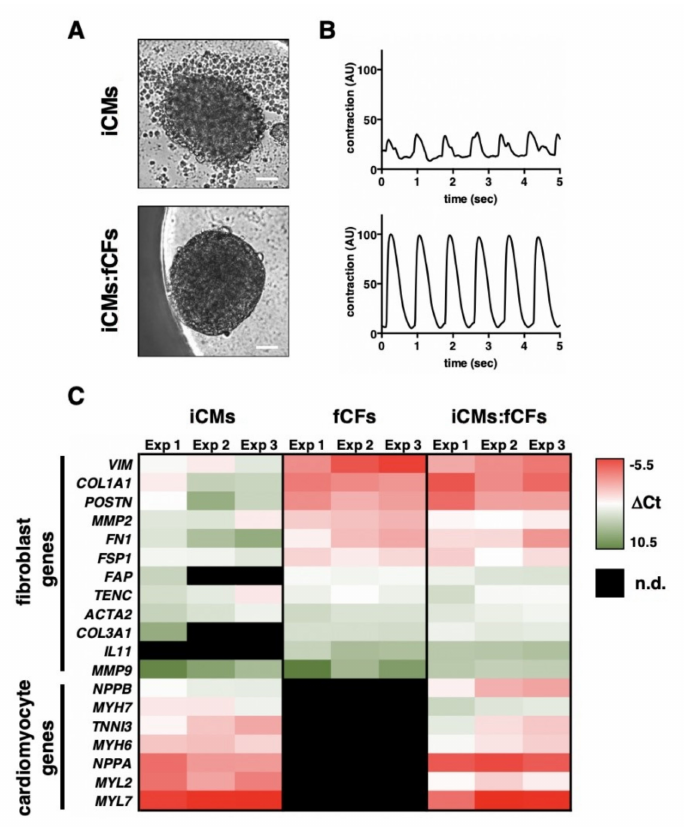
Figure 1. Characteristics of cardiac microtissues. Panel ( A ) illustrates typical morphologies (bar = 50 µ m) and panel ( B ) shows typical contraction patterns of cardiac microtissues generated using iPSC-derived cardiomyocytes (iCMs) only (top) or iCMs mixed with foetal cardiac fibroblasts (fCFs) in a ratio of 4:1 (iCMs:fCFs, bottom). Representative contractions are available in the Supplementary Materials (Videos S1 and S2). A heat map in panel ( C ) indicates expression of cardiomyocyte and fibroblast genes in microtissues containing iCMs only (left), fCFs only (center) or iCMs:fCFs (right). Each segment indicates the average ( n = 3–5) expression of one experiment. Lower − ∆ C t values indicate higher relative expression. n.d.—not